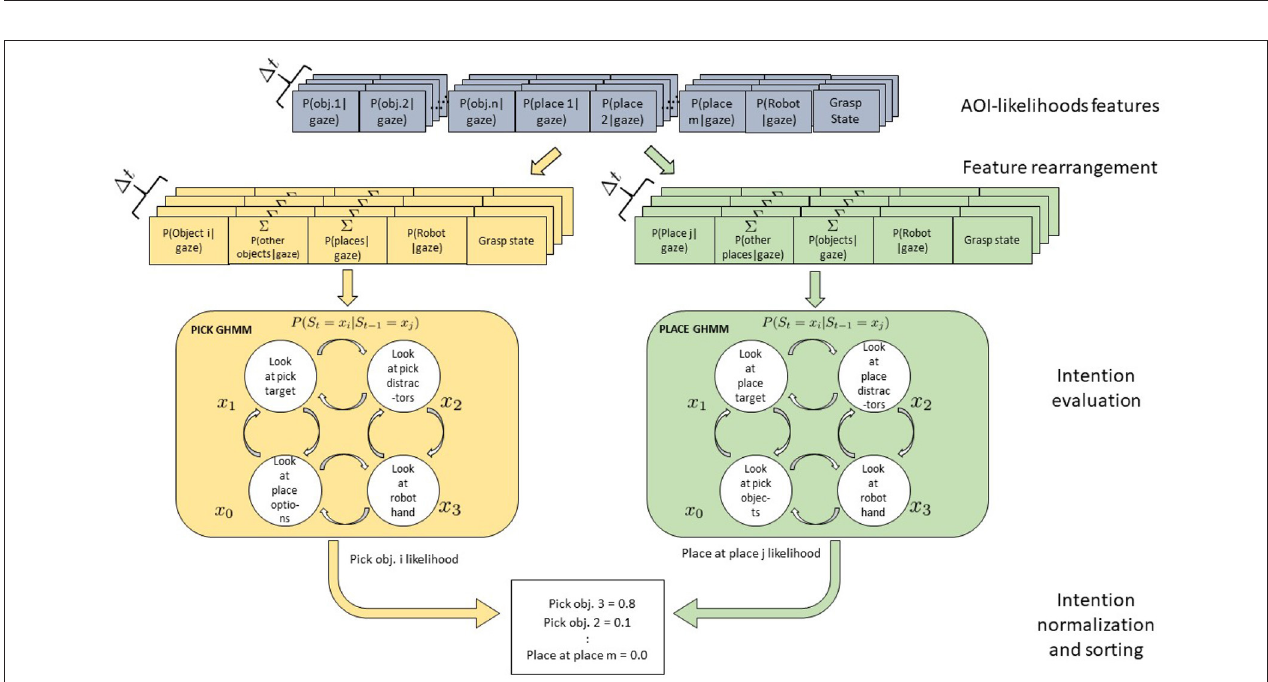
FIGURE 13 | Normalized confusion matrices for the two picking arrangements. Errors are mostly made mistaking neighboring locations but still classifying the task correctly.